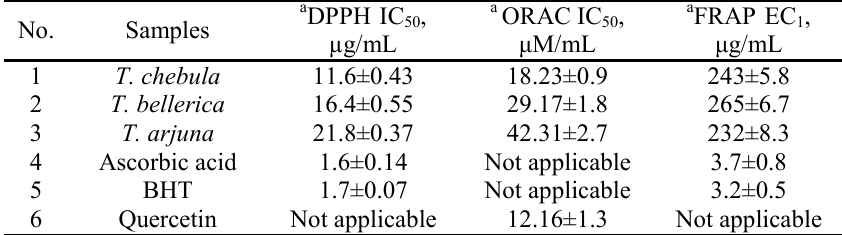
Table 2. Antioxidant activities of Terminalia chebula , T. bellerica and T. arjuna methanolic leaf extracts in DPPH, ORAC and FRAP